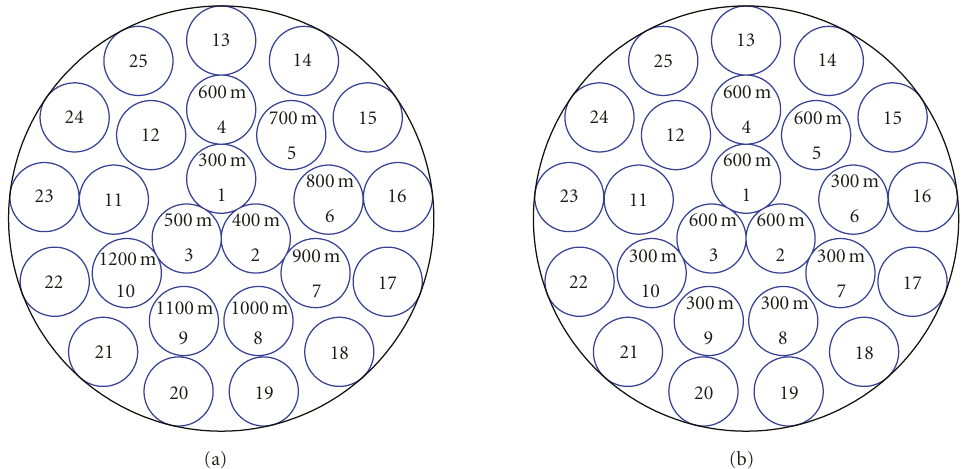
Figure 2: Cross-section of the binder and corresponding VDSL loop lengths: (a) distributed Scenario 1, (b) near-far Scenario 2.